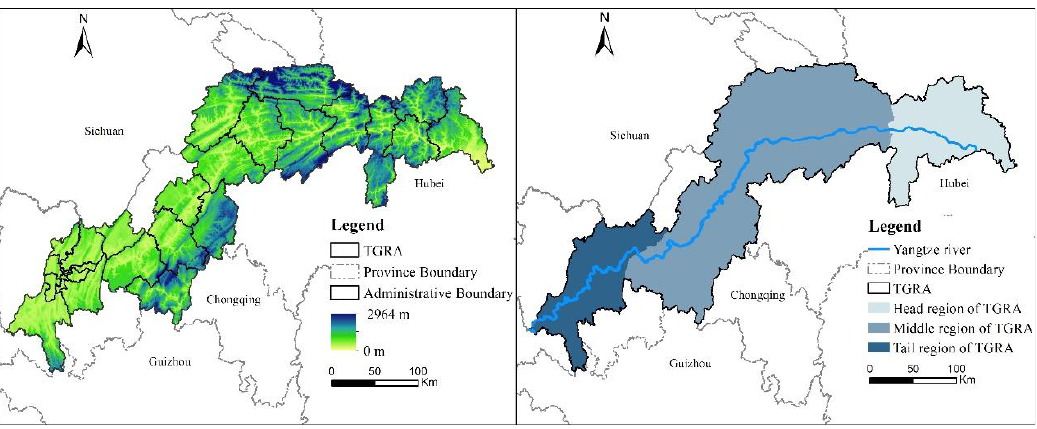
Figure 1. Location map of the TGRA.